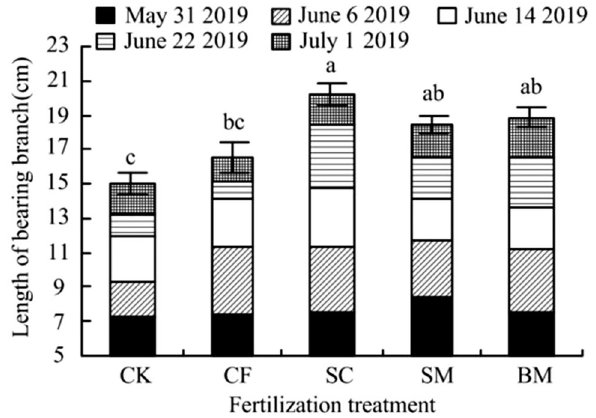
Figure 1. Effects of different fertilizer treatments on bearing a branch of Pear-jujube. Note : At different levels, each population mean follows a normal distribution with the same variance. The least significant difference (LSD) method was selected for analysis of variance in DPS software. Different lowercase letters indicate significant difference between treatments ( P <